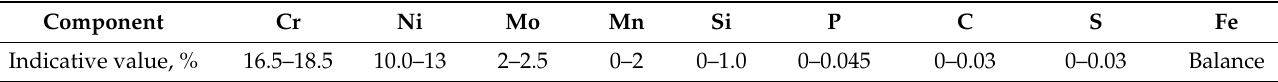
Table 1. Chemical composition of the 316L steel [32].